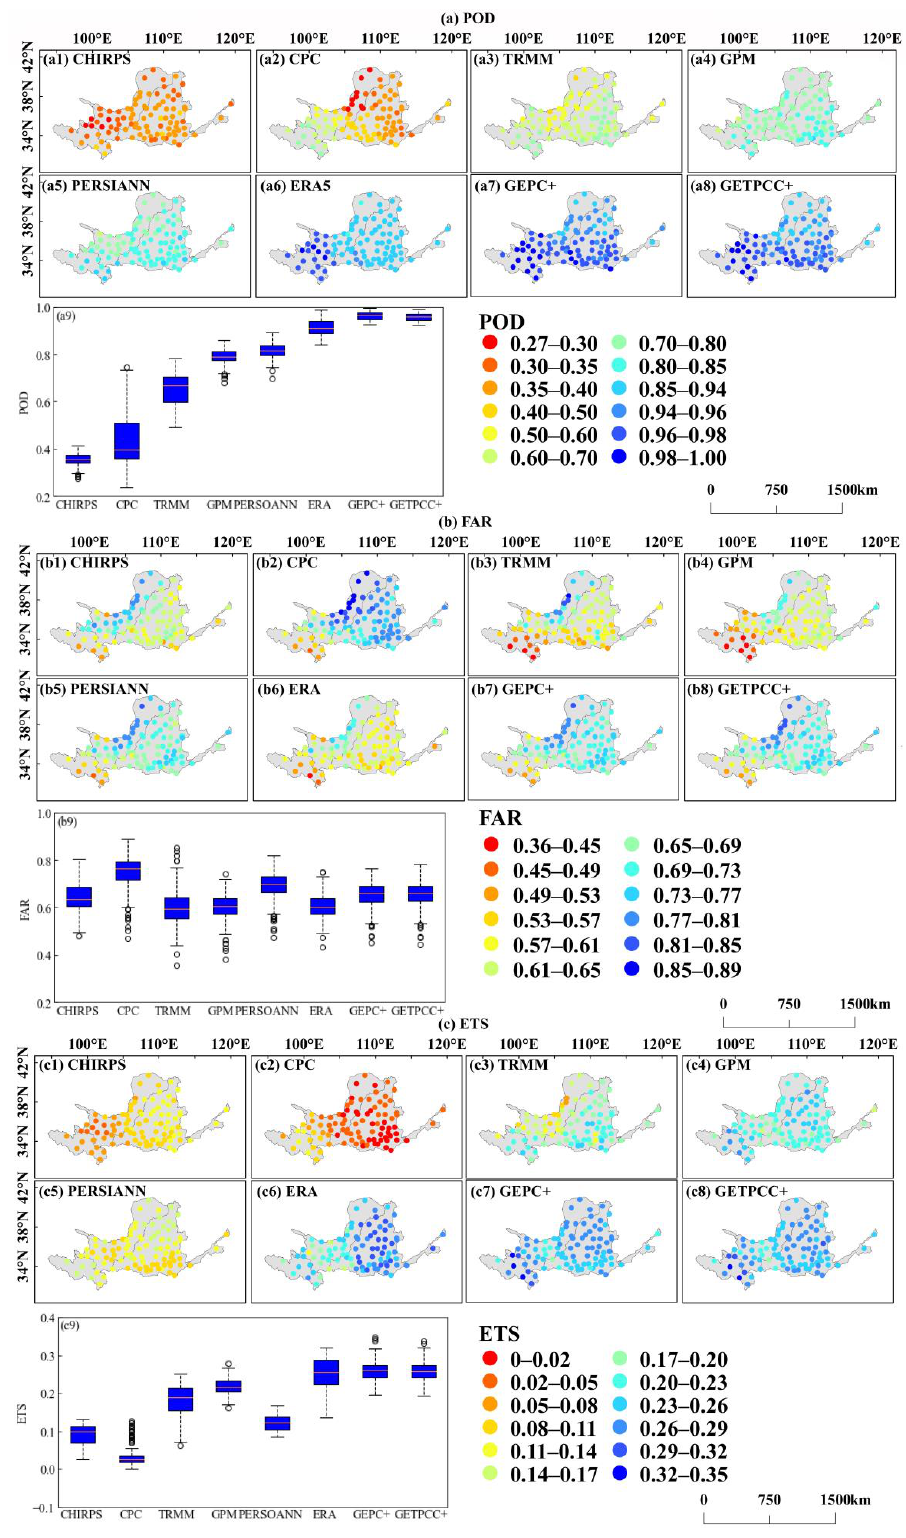
Figure 6. Spatial pattern of the probability of detection (POD, ( a1 – a9 )), the false alarm ratio (FAR, ( b1 – b9 )), and the equitable threat score (ETS, ( c1 – c9 )). ( a9 ) POD, ( b9 ) FAR, ( c9 ) ETS box diagram for all station